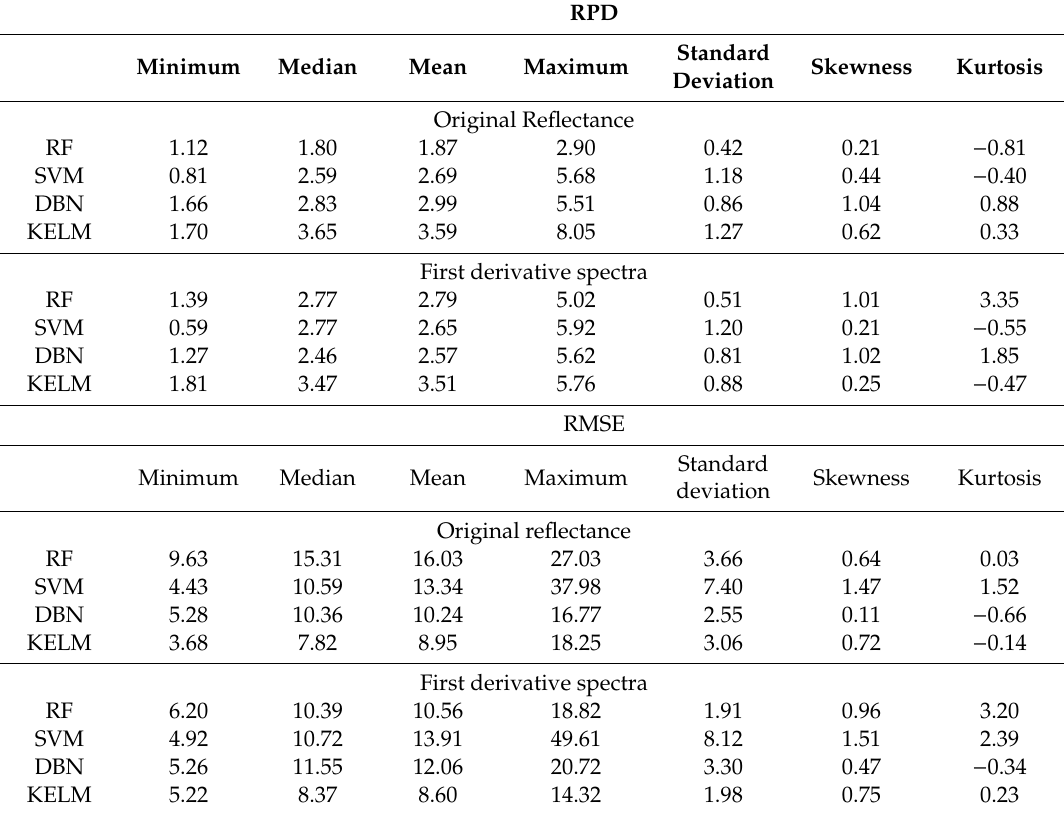
Table 2. Ratio of performance to deviation (RPD) and root-mean-square error (RMSE) for each regression model (statistical results are based on 100 repetitions). RF: random forest, SVM: support vector machine, DBN: deep belief nets, KELM: kernel-based extreme learning machine. RPD Minimum Median